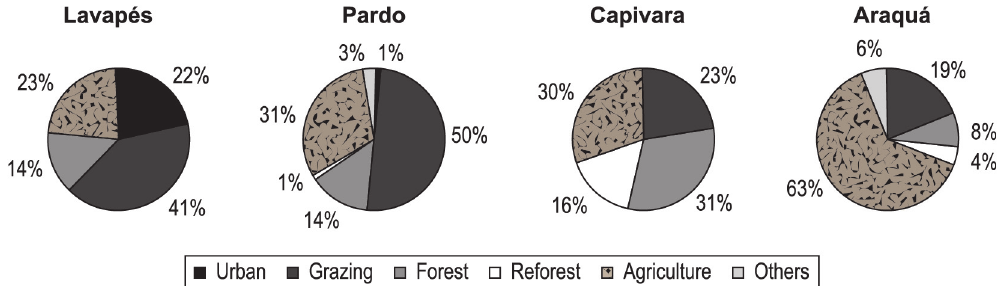
Figure 7. Lavapés (Orsi, 2004), Pardo (Ribeiro and Campos, 2007), Capivara (Araújo Junior et al., 2002) and Araquá (Refosco, 1996) catchment uses. Table 6. Channel width, depth (transversal section mean value), flow and velocity (transversal section mean value) measured in Araquá, Capivara, Lavapés and Pardo Rivers during the rainy and dry (in bold) periods of 2007. Sampling